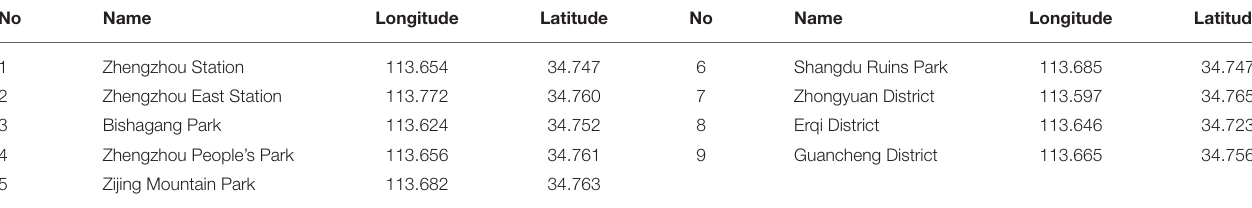
TABLE 1 | Geographical information of three types of mobile emergency stations in Zhengzhou.